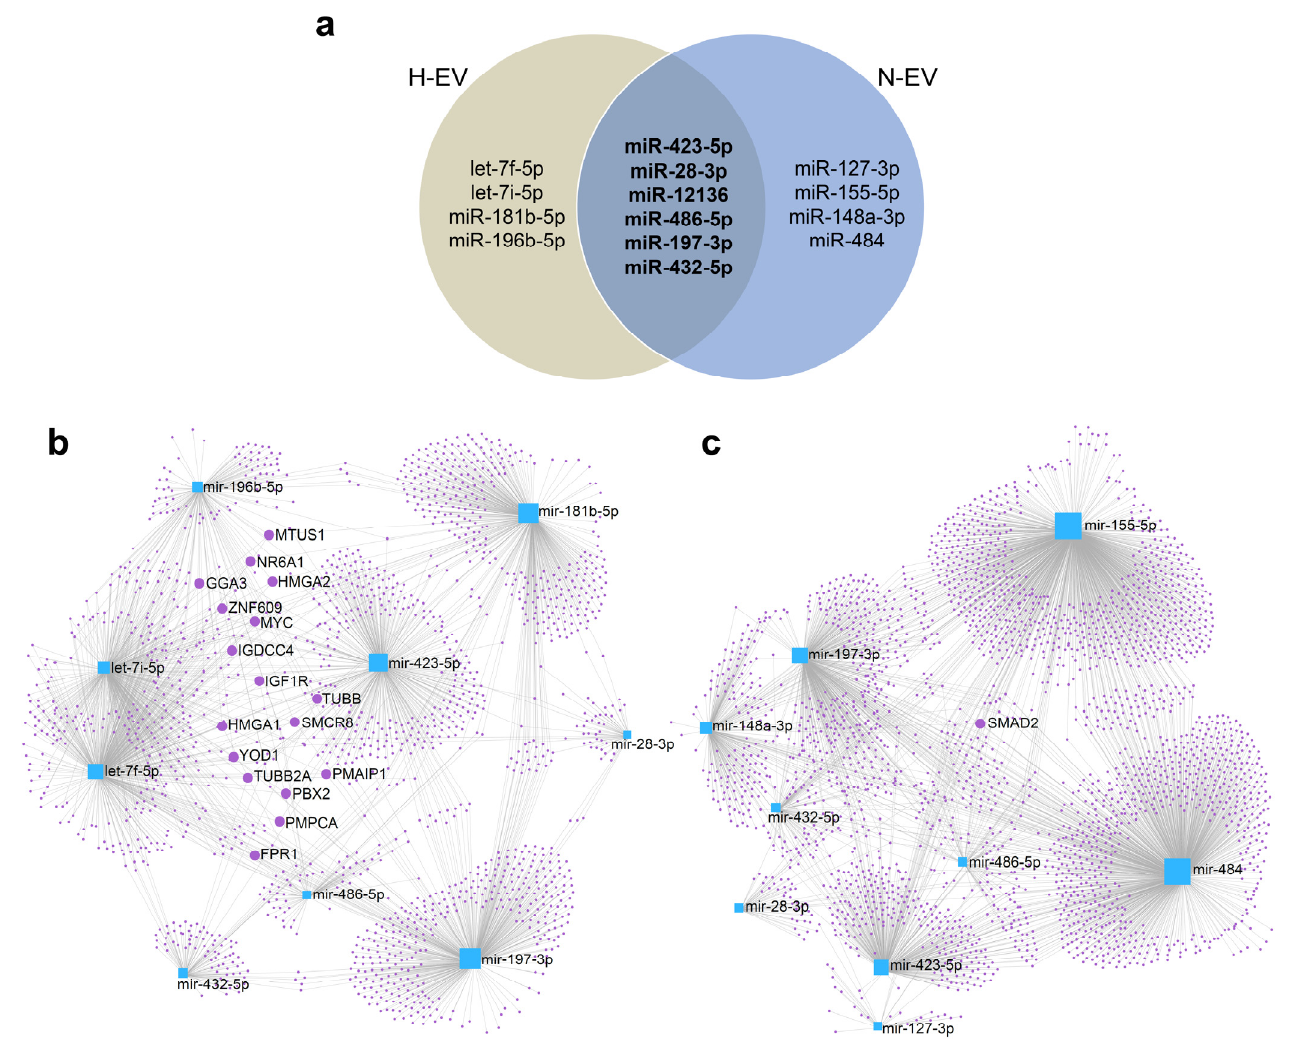
Figure 4. Identification of higher expressed miRNA targets. ( a ) Venn diagram comparing the miRNAs enriched in N-EVs and/or H-EVs (vs. cells) with higher CPM. The miRNAs presented in the two EVs are highlighted in bold. ( b ) Network of top 10 miRNAs enriched in H-EVs (vs. H-cells) and its target mRNAs. ( c ) Network of top 10 miRNAs enriched in N-EVs (vs. N-cells) and its target mRNAs. The highlighted genes are targets of 4 or more miRNAs.